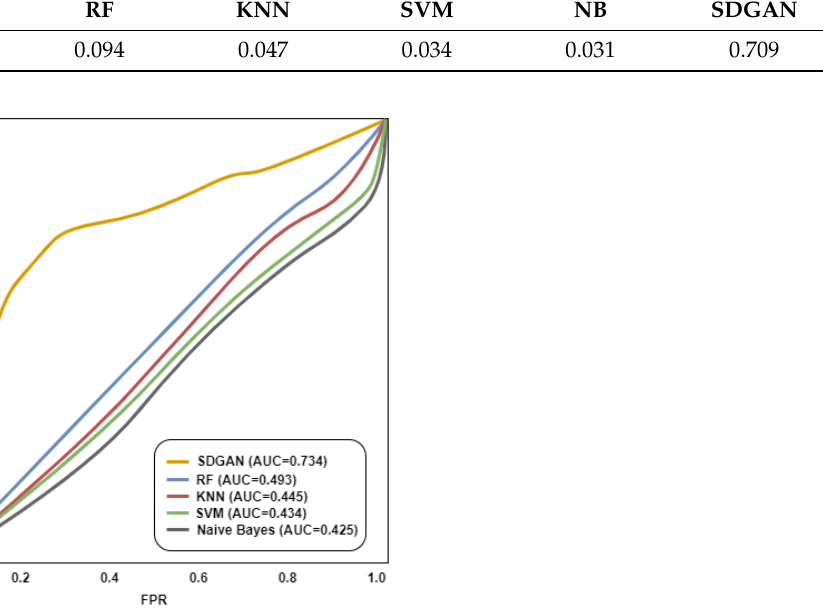
Figure 8. ROC curves of ML-based defense DDoS detection and SDGAN on unseen adversarial DDoS attacks.